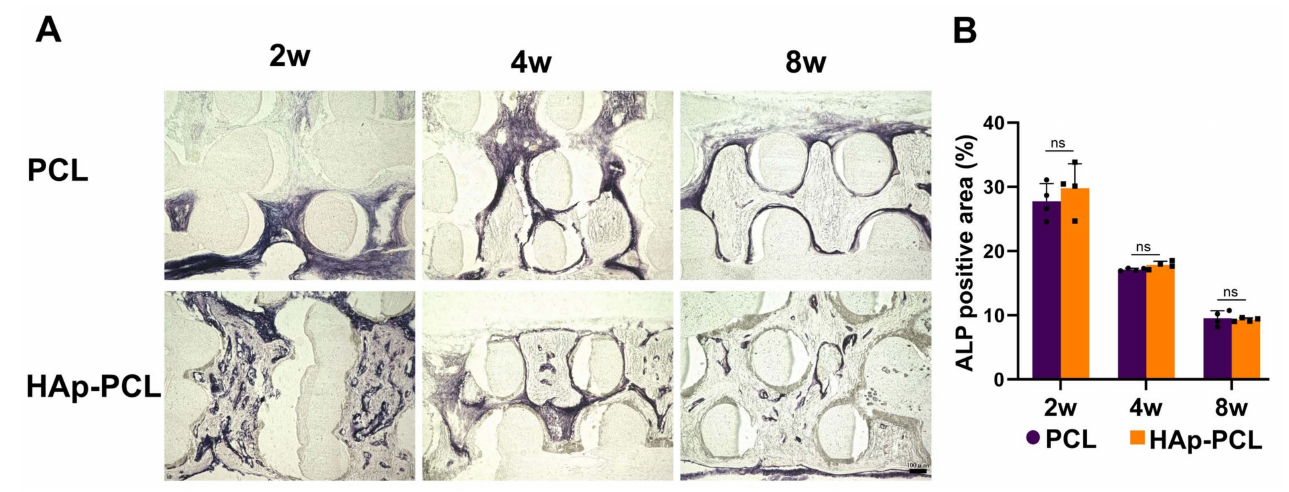
Figure 7. Alkaline phosphatase (ALP) staining for the sectioned tissue inside the scaffold at 2, 4, and 8 weeks after implantation of PCL or HAp-PCL into the critical-sized calvaria bone defect in rats. ( A ) Representative staining images. Scale bar is 100 µ m. ( B ) Time profiles in percentages of ALP-positive area. n.s.; no significance.